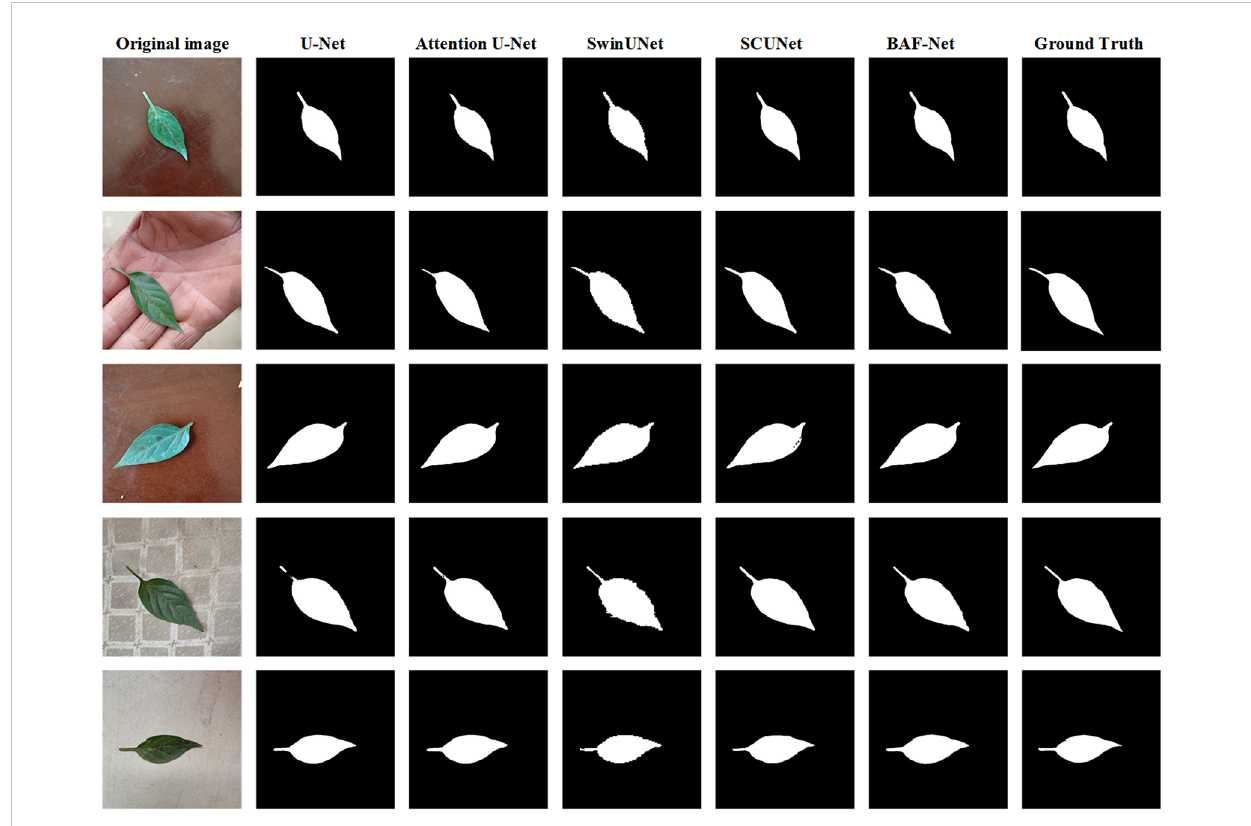
FIGURE 7 Examples of the predicted results using fi ve different model on the HPL dataset. From the 1 st column to 7 th column: the original image, the predicted results using the U-Net, attention U-Net, Swin-UNet, SCUNet, and our model,